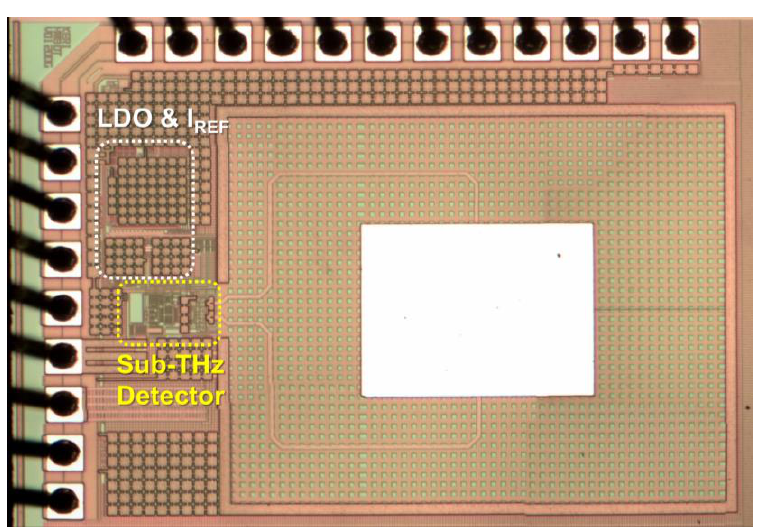
Figure 6. Die photograph of the differential CMOS sub-THz detectors (active dimensions: 390 μm × 220 μm without the antenna area).